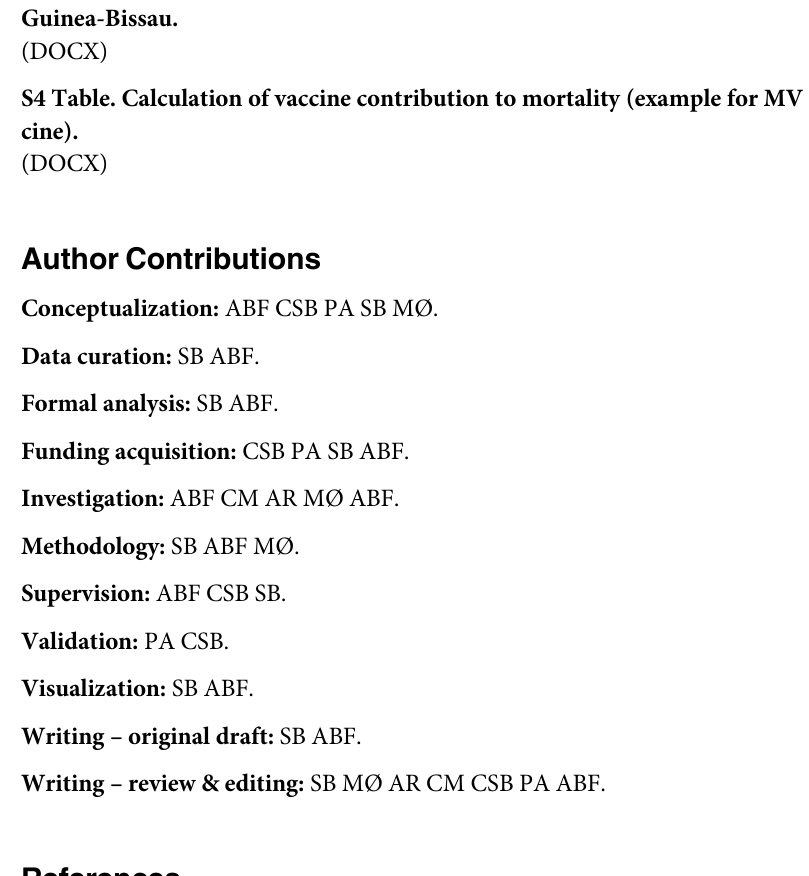
S1 Table. Hazard ratios in the 1992–3 and 2002–3 birth cohorts in monthly intervals— Overall and by sex. S2 Table. Risk factors for infant mortality in the 1992–3 and 2002–3 birth cohorts (multi- variate analysis)—by age groups. S3 Table. Child health interventions provided to infants born in 1992–3 and 2002–3 in Guinea-Bissau. S4 Table. Calculation of vaccine contribution to mortality (example for MV as last vac-